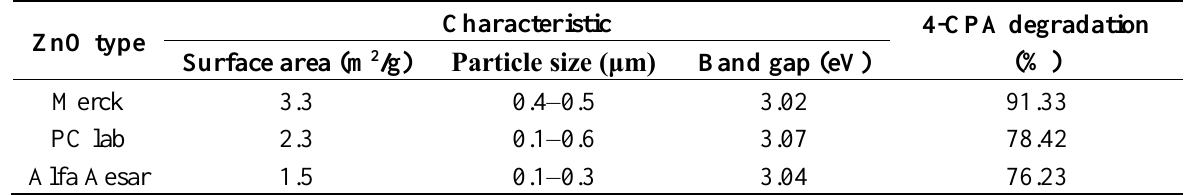
Table 6. Characteristic of three types of commercial